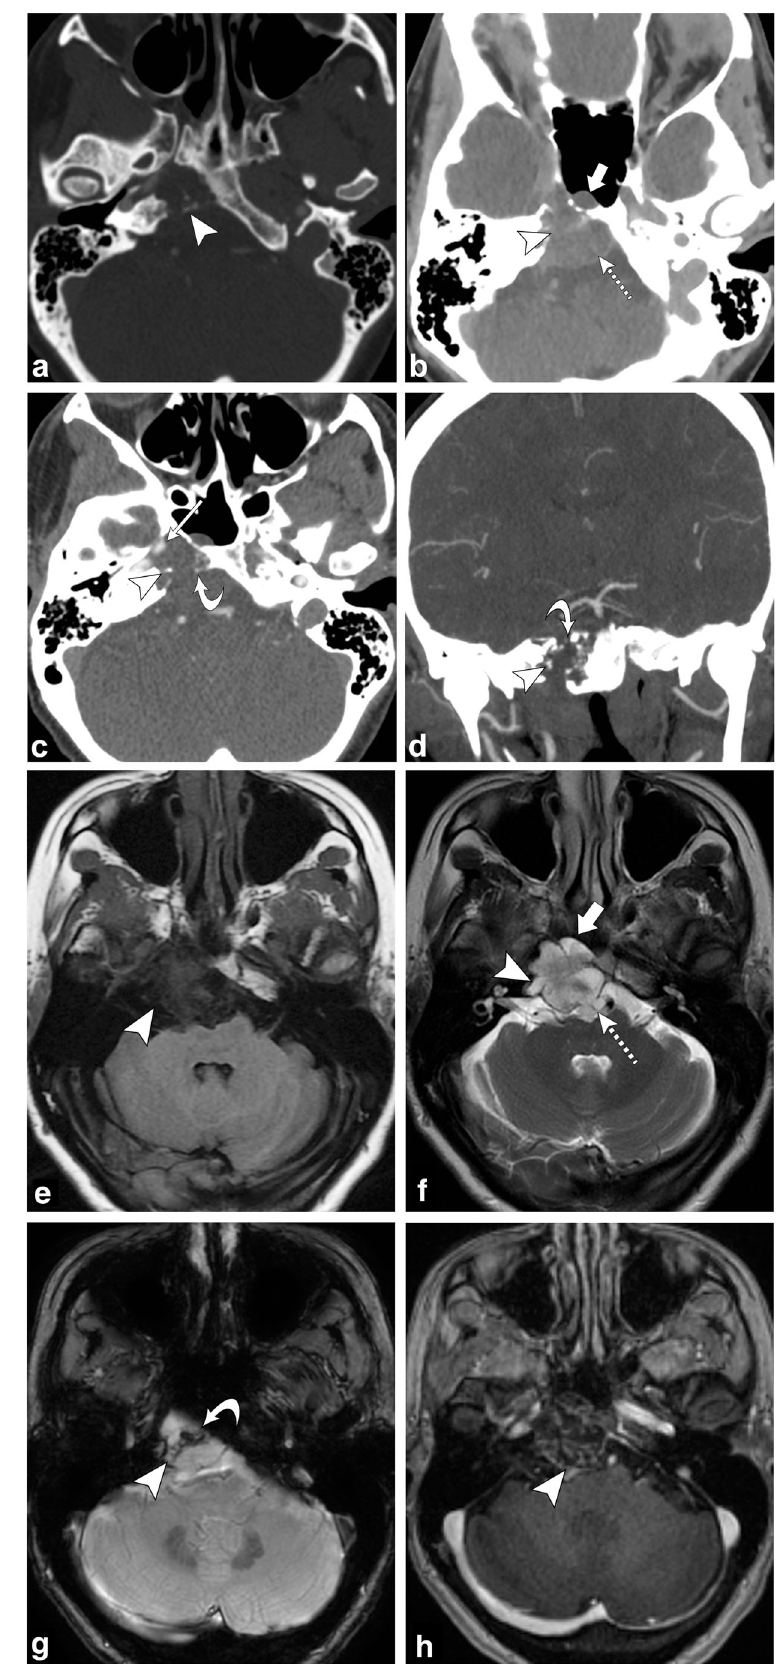
Fig. 20 Chondrosarcoma. Axial non-contrast CT ( a ) shows an osteolytic destructive lesion involving the right petro-occipital junction and clivus ( arrowhead ). Axial contrast-enhanced CT ( b ) demonstrates this lesion to have a soft-tissue component extending anteriorly into the sphenoid sinus ( thick arrow ) and posteriorly into the prepontine cistern with mass effect on the pons ( dashed arrow ). Axial ( c ) and coronal ( d ) CT angiogram images demonstrate involvement of the right petrous carotid canal ( arrowheads ) with the lesion surrounding the right internal carotid artery ( thin arrow ). Note the punctate calcifications (chondroid matrix) within the mass ( curved arrow ). Axial T1-weighted ( e ) and axial T2-weighted ( f ) images show a lobulated lesion involving the right petro-occipital junction and clivus ( arrowhead ). Note the extension of the lesion anteriorly into the sphenoid sinus ( thick arrow ) and posteriorly into the prepontine cistern with mass effect on the pons ( dashed arrow ). Axial SWAN ( g ) shows internal foci of low signal, consistent with calcifications ( curved arrow ). Post-contrast axial T1-weighted imaging ( h ) demonstrates heterogeneous ( “ whorls ” of) enhancement ( arrowhead